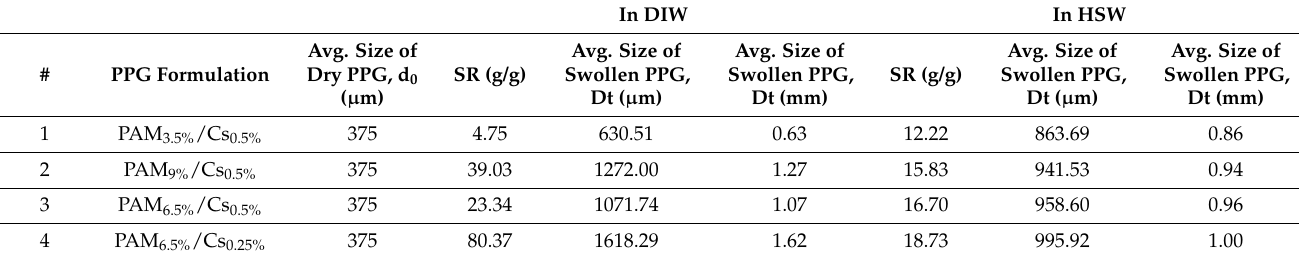
Table 3. Particle size estimation of the swelled PAM/Cs PPG in DIW and HSW. In DIW In